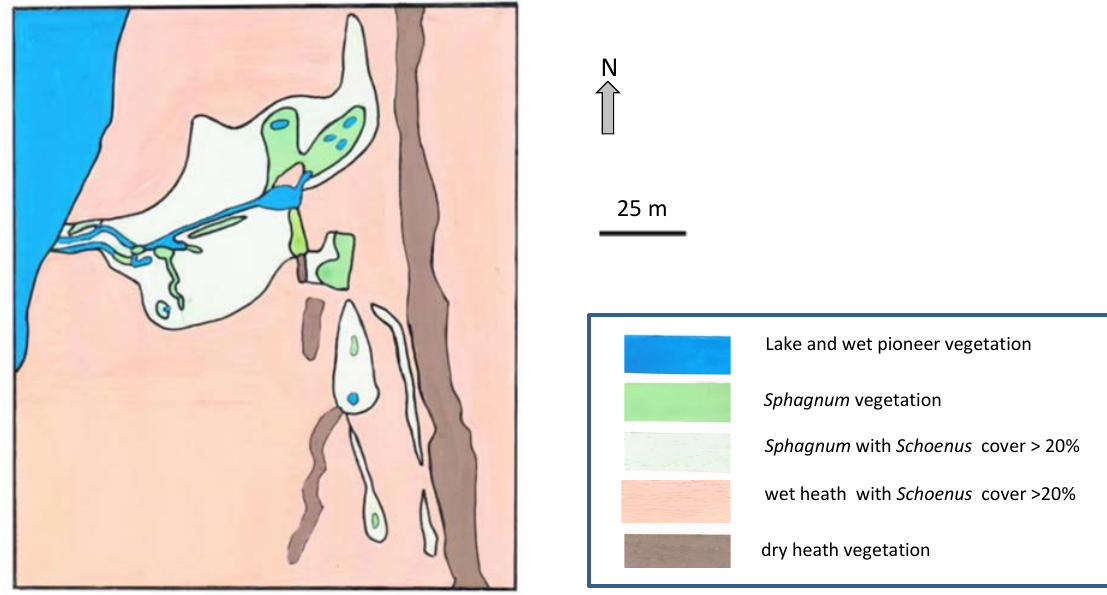
Figure 3. Vegetation map of the study area in Roundstone Bog. The colour codings for vegetation types apply also to Figures